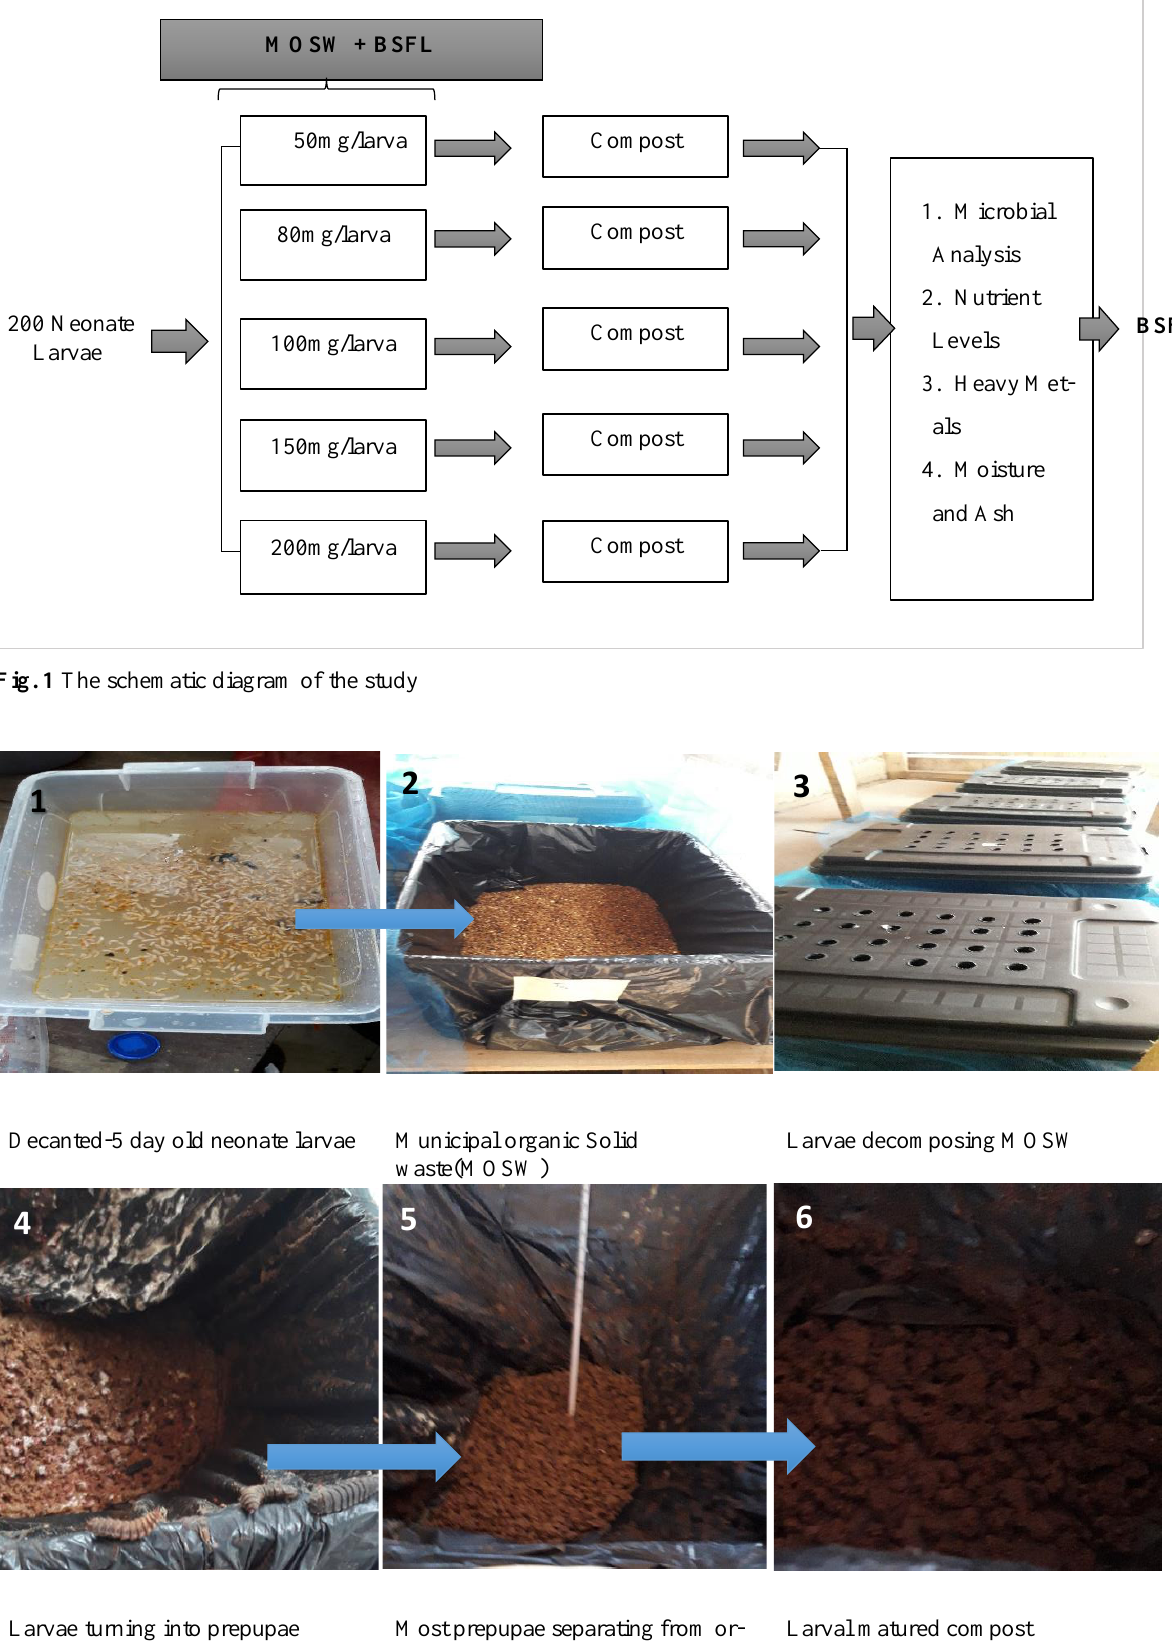
Fig. 2 Some pictures of the experimental design